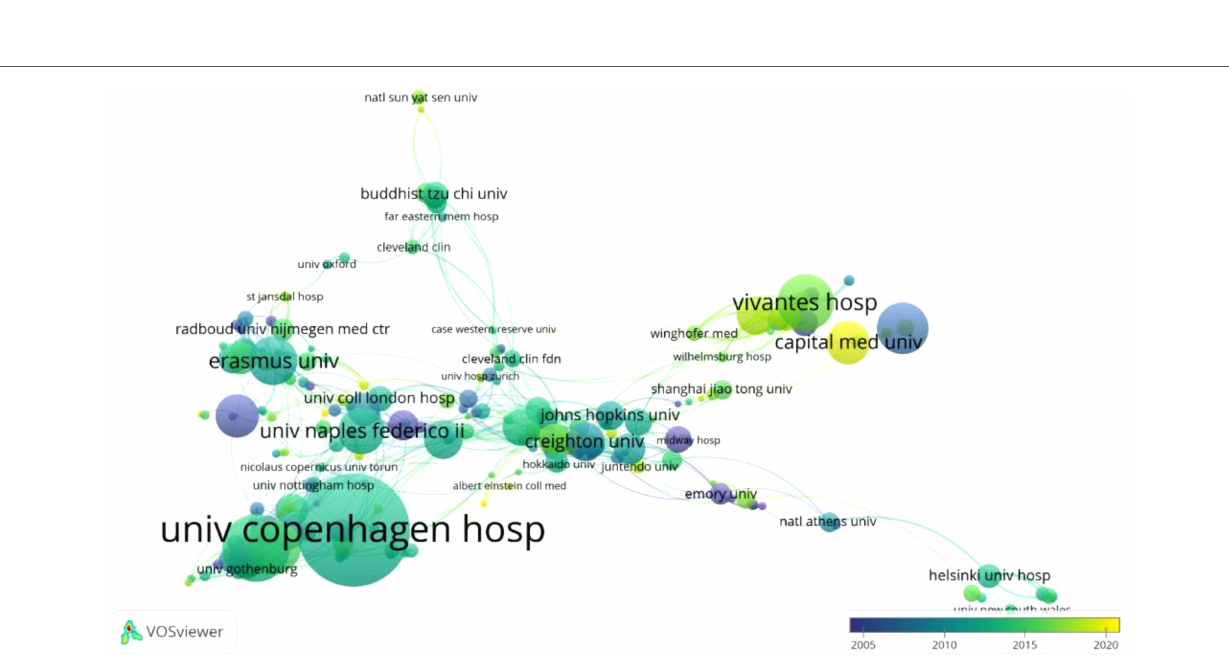
FIGURE 4 Bibliographic coupling network of institutions with the highest scienti fi c production in the web of science